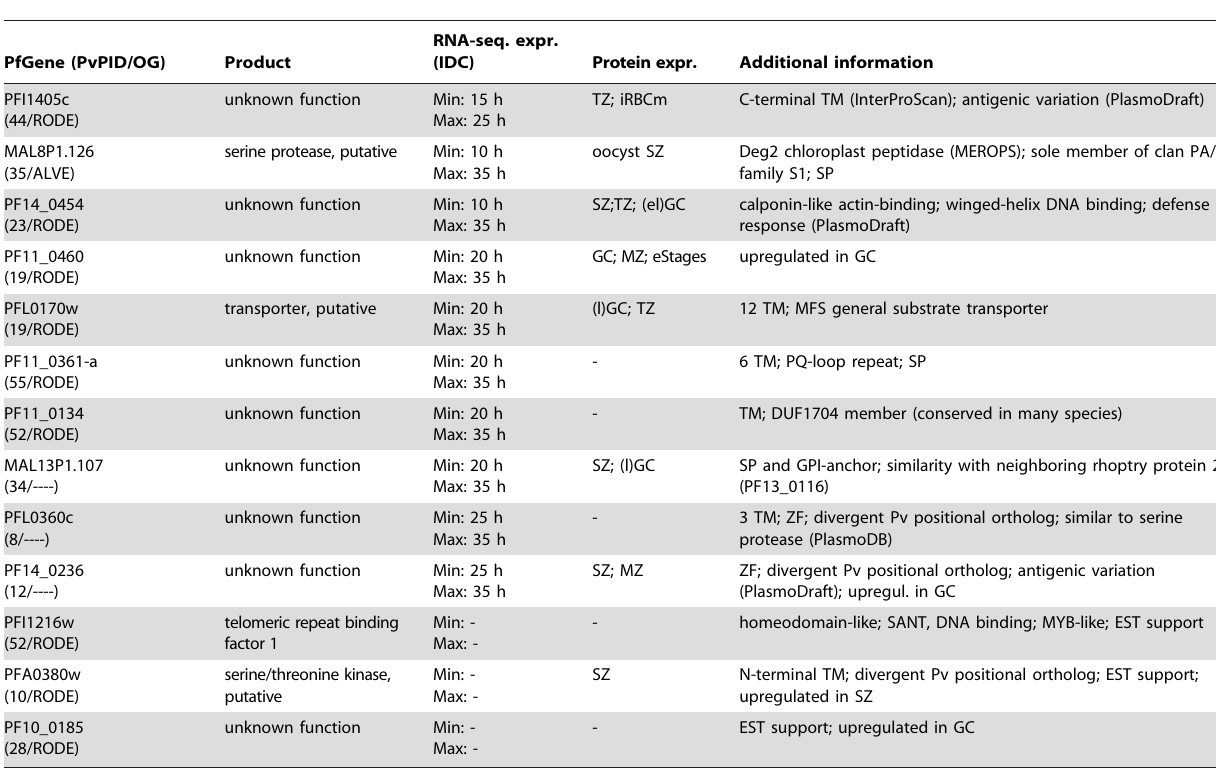
Table 2. Genes shared between P. falciparum and P. vivax but absent in P. knowlesi .